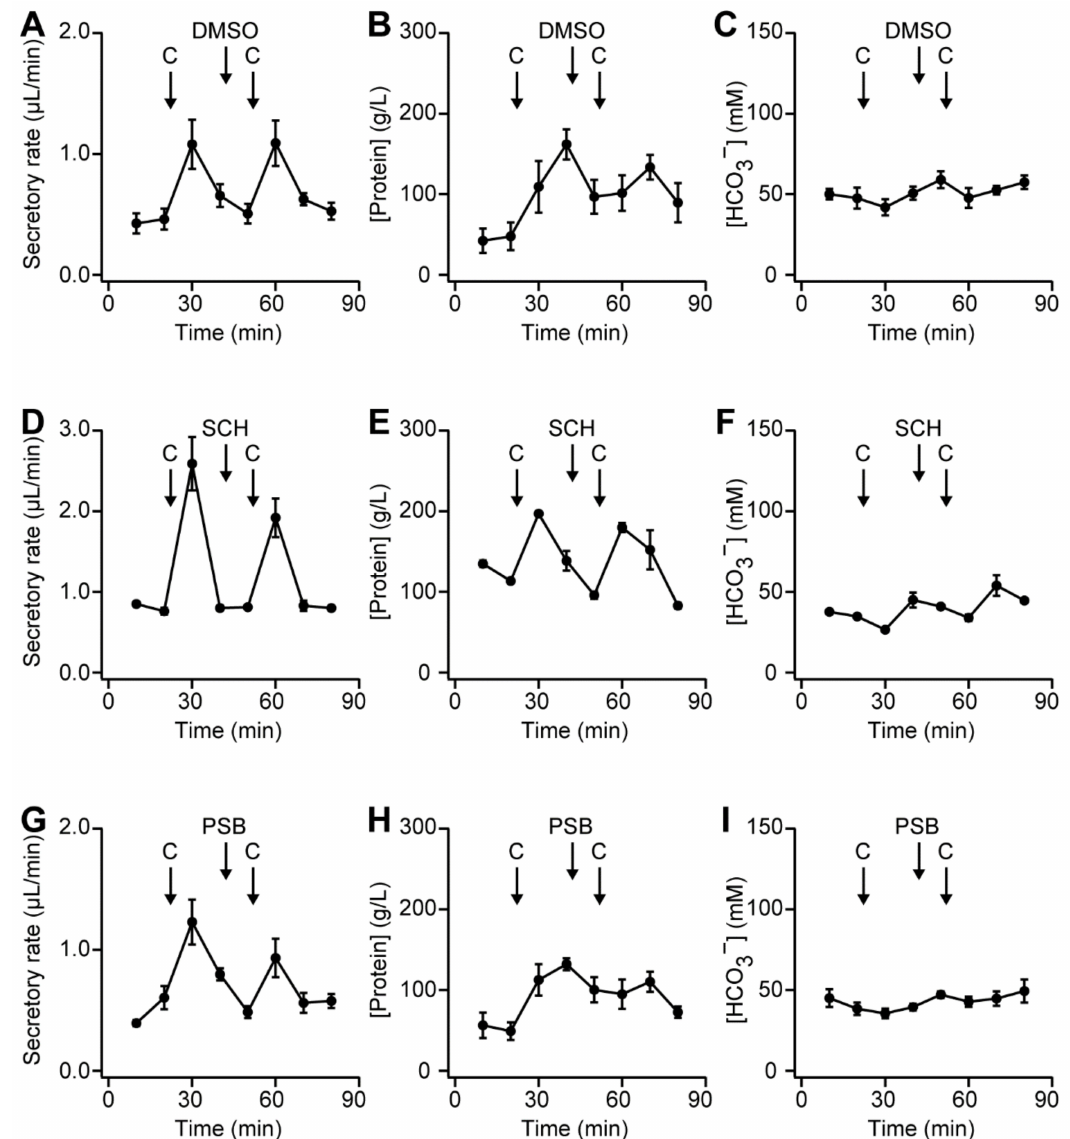
Figure 7. ( A ) Time-course of secretory rate of pancreatic juice from the anesthetized rats, which were intravenously injected with cholecystokinin (CCK, 0.1 nmol / kg body weight) and vehicle control (0.1% DMSO in saline, 1 mL / kg body weight), indicated by arrows ( n = 4 rats). The concentrations of protein ( B ) and HCO 3 − ( C ) in pancreatic juice. ( D – F ) Time-courses of experiments in the anesthetized rats, which were intravenously injected with cholecystokinin and 2-(2-Furanyl)-7-[3-(4-methoxyphenyl)propyl]-7 H -pyrazolo[4,3- e ][1,2,4]triazolo[1,5- c ]pyrimidin-5-amine (SCH-442416; SCH, 10 nmol / kg body weight) ( n = 2 rats). ( G – I ) Time-courses of experiments in the anesthetized rats, which were intravenously injected with cholecystokinin and 8-[4-[4-(4-chlorophenzyl)piperazide-1-sulfonyl)phenyl]]-1-propylxanthine (PSB 603; PSB, 10 nmol / kg body weight) ( n = 5 rats). Neither SCH-442416 nor PSB 603 increased the concentrations of protein ( E , H ), and both had a negligible e ff ect on the HCO 3 − concentration ( F , I ). 2.8. Expression of ADORA2B Associated with Poor Prognosis of Pancreatic